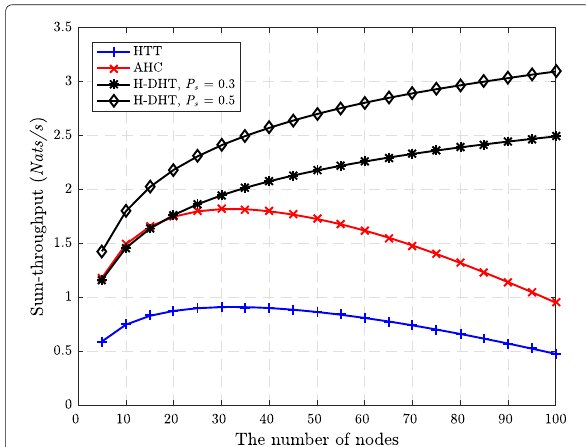
Fig. 7 Sum-throughput according to the number of nodes. Figure 7 shows the sum-throughput according to the number of nodes in the HTT, AHC, and the proposed H-DHT. As we can see in the Fig. 7, the throughput of both HTT and AHC protocols decreases when the number of nodes increases, because of the network overhead caused by SI transmission. However, the sum-throughput of the H-DHT protocol increases according to the number of nodes, because the H-DHT protocol permit only the nodes, which require reliable data transmission, to send SI message to the H-AP